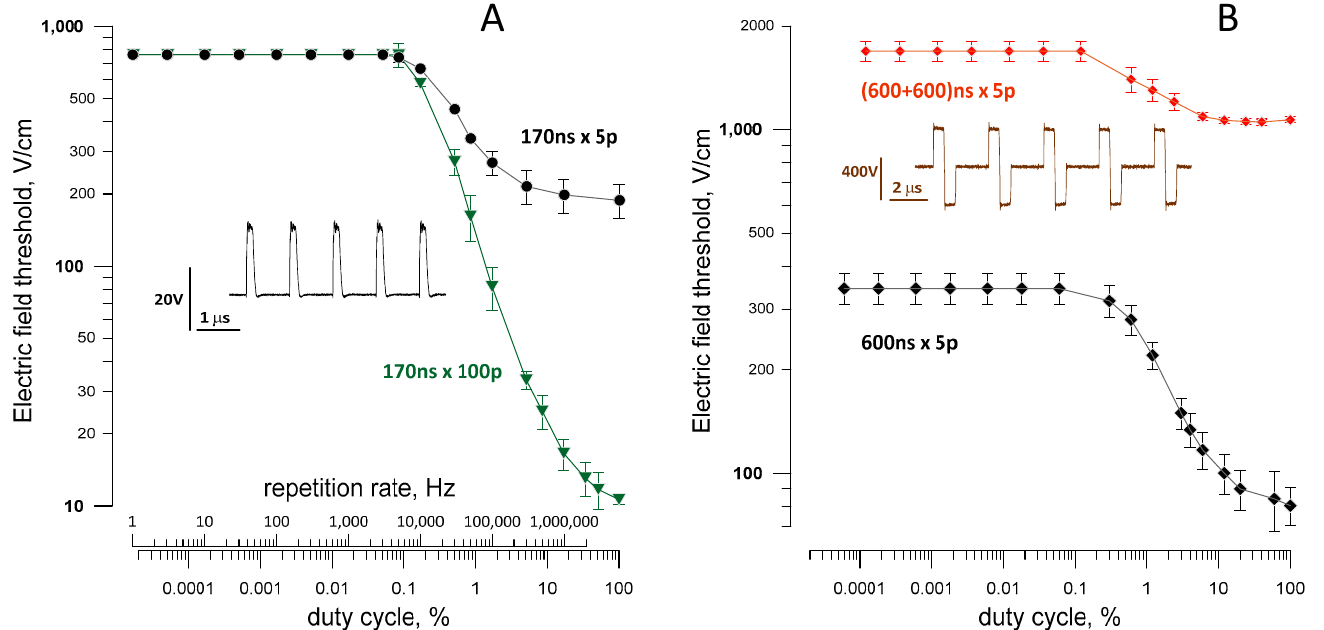
Figure 5. Temporal summation reduces the excitation thresholds for high-rate nsPEF bursts. ( A ) The effect of the duty cycle and pulse repetition rate on the excitation thresholds for bursts of 5 and 100 unipolar 170-ns pulses (170 ns × 5p and 170ns × 100p). The inset is a sample waveform for a 5-pulse burst at 1 MHz. ( B ) Different efficacy of the threshold reduction for bursts of unipolar and symmetrical bipolar pulses (600ns × 5p and (600 + 600)ns × 5p). The inset is a sample waveform for a 5-pulse burst of bipolar pulses at 0.33 MHz. Mean ± SE, n = 3–7.